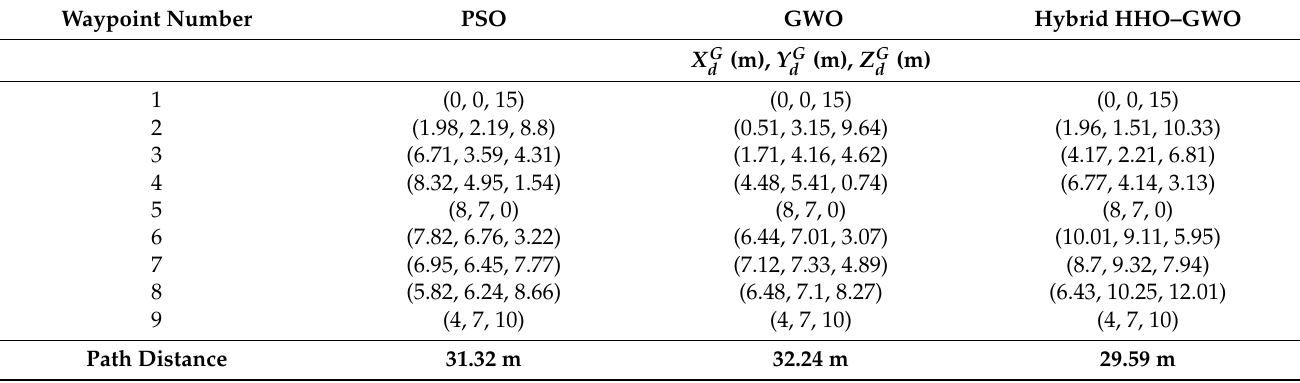
Figure 9. The optimized path for Map 2 ( a ) using PSO, ( b ) using GWO, and ( c ) using hybrid HHO–GWO. Table 4. Optimized waypoints for Scenario